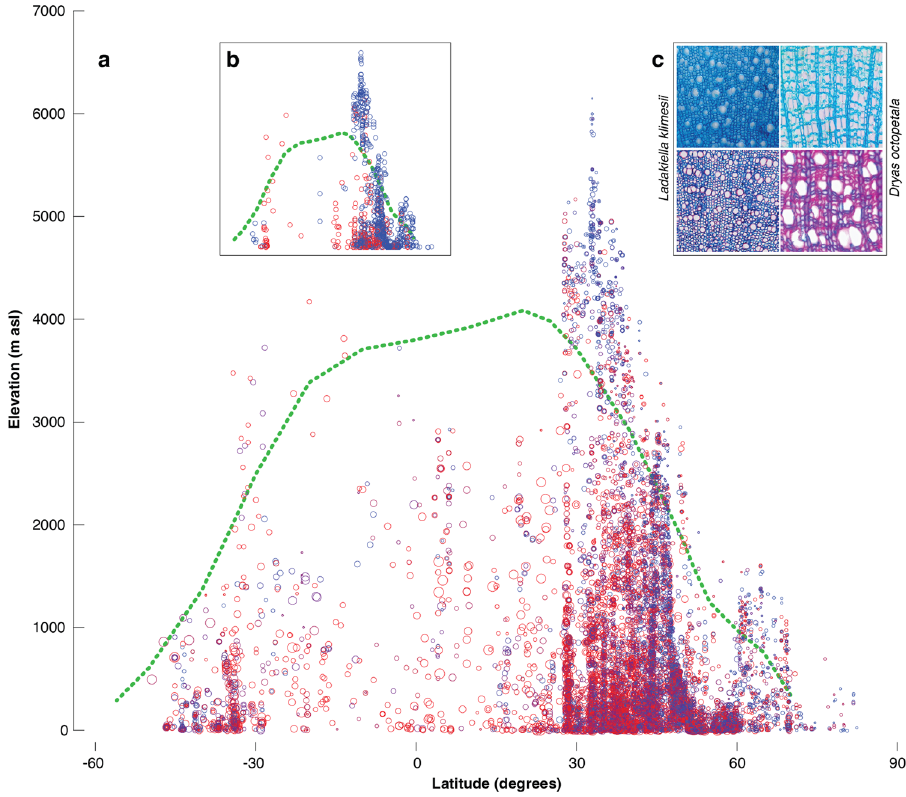
Fig. 6 Global distribution of plant cell wall ligni fi cation. a Elevational and latitudinal distribution of DCWL that ranges from less ligni fi ed (blue circles) to more ligni fi ed (red circles). Circle sizes refer to vertical plant heights from two centimetres and circa 40 m (small to large). The green line roughly resembles the temperature-induced global treeline position 1,46 . b The same plot but limited to the 2nd and 98th DCWL percentiles (see Supplementary Fig. 4 for lifeform differences). c Double-stained stem cross-section (top left) of a four cm small Ladakiella klimesii that was growing for more than 20 years under very harsh conditions at around 6150 m asl in the Ladakh desert, Himalaya 11 . The stem of this plant reveals overall less ligni fi ed cell walls, whereas other individuals of the same species that were growing at lower elevations show more ligni fi ed wood vessels (bottom left). The same pattern is evident for Dryas octopetala from a high-latitude site in coastal east Greenland, showing less ligni fi ed wood (top right) compared to samples of the same species growing in warmer conditions in the European Alps (bottom right). All photos are original and have been taken by one of the